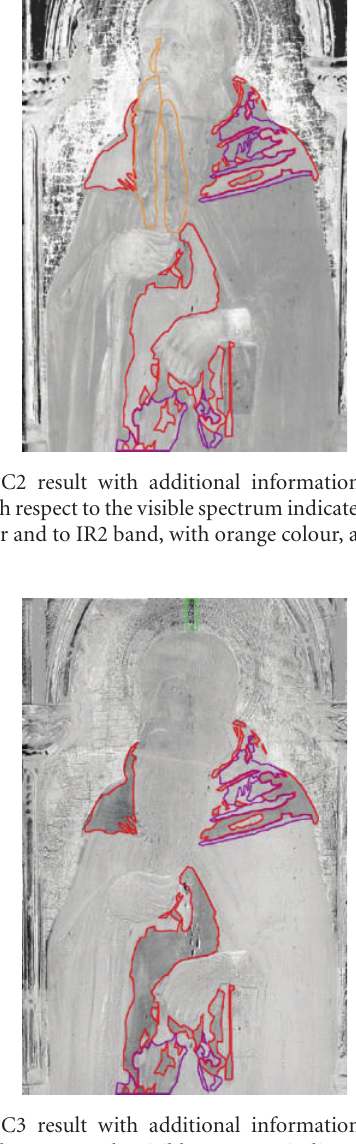
Figure 5: PC3 result with additional information and features provided with respect to the visible spectrum indicated with red and purple colour and to IR2 band, with green colour, as